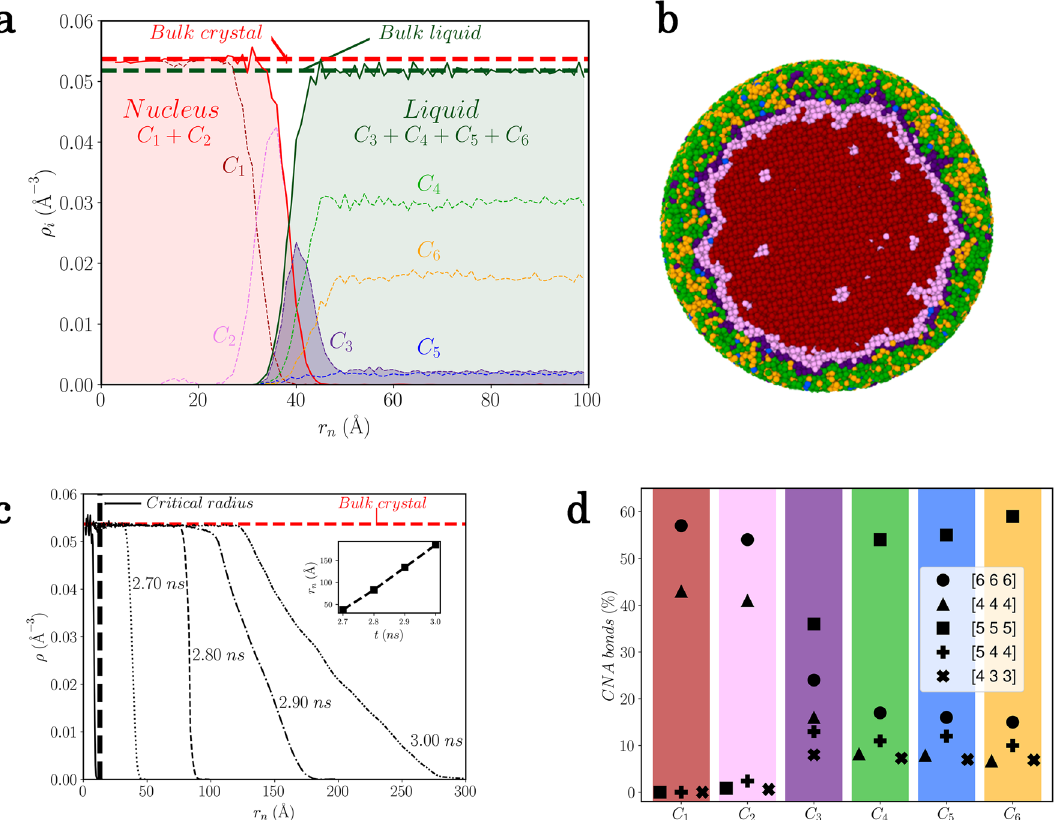
Figure 3. Translational and bond-orientational order parameters for Ta. ( a ) Radial density profile of the largest nucleus during the growth at 2.7 ns along the T = 1900 K isotherm. The red and blue dashed horizontal lines correspond respectively to the average bulk crystalline density and average bulk undercooled liquid without nucleation events, both being simulated at T = 1900 K at ambient pressure. ( b ) Corresponding slice of the nucleus through its centre and the surrounding liquid where atoms have been coloured according to the cluster they belong to (see Fig. 1d). ( c ) Total radial density profile of the largest nucleus during growth at times corresponding to Fig. 2 before solidification. Inset: time evolution of the radius of the nucleus. ( d ) Bond- orientational order in terms of bonded pairs of the Common-Neighbor Analysis 28 for each cluster of the